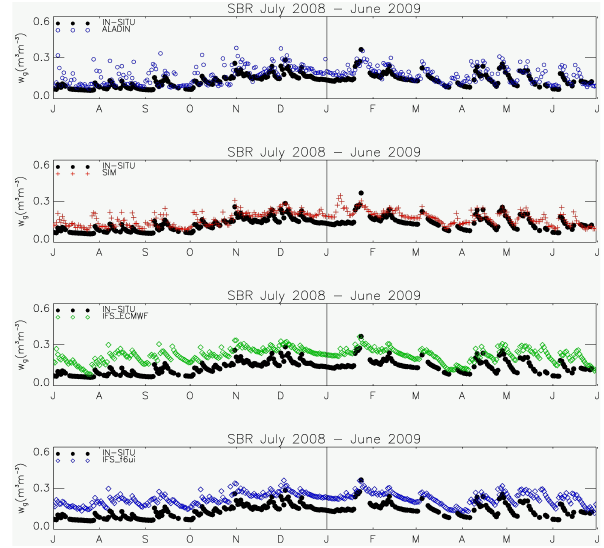
Fig. 7. Comparison of in situ surface soil moisture at Sabres (SBR) with simulations provided by (from top to bottom): (i) the ALADIN operational NWP model (OI analysis, T 2m , RH 2m ) , (ii) the SIM hydro-meteorological model, (iii) the ECMWF IFS (OI analysis, T 2m , RH 2m ) and (iv) the ECMWF IFS using a SEKF analysis (AS- CAT SSM, T 2m , RH 2m )